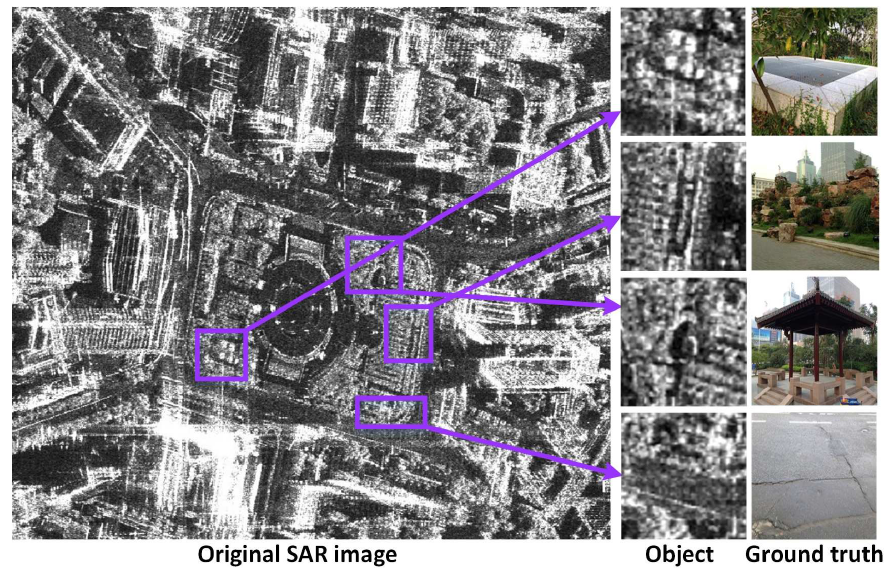
Figure 1. Correspondence between different objects in Synthetic Aperture Radar (SAR) image and their ground truth. SAR image is characterized by bright and dark spots, stripe, or various combinations of them; different objects exhibit distinct visual